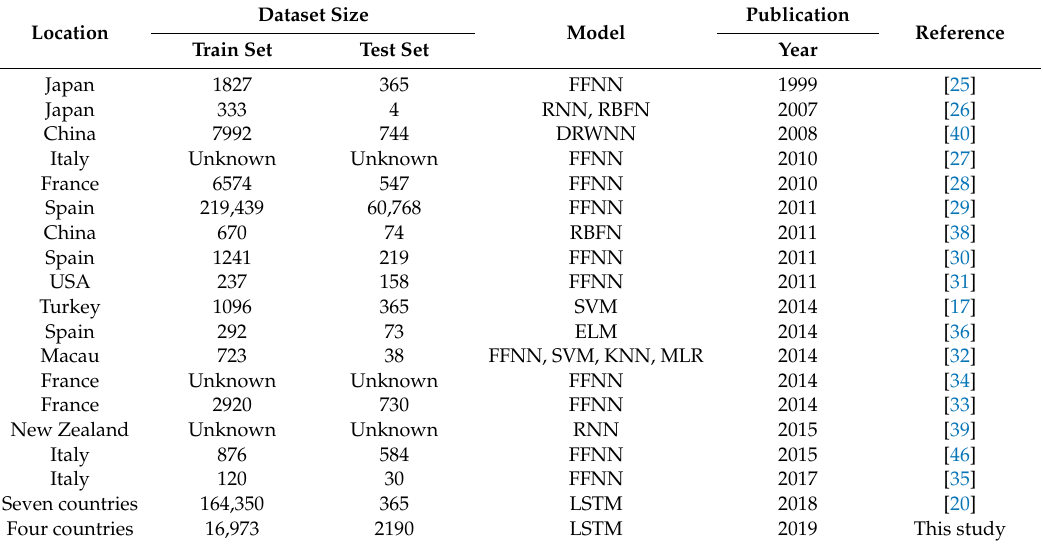
Table 1. Previous studies on a day-ahead solar irradiance